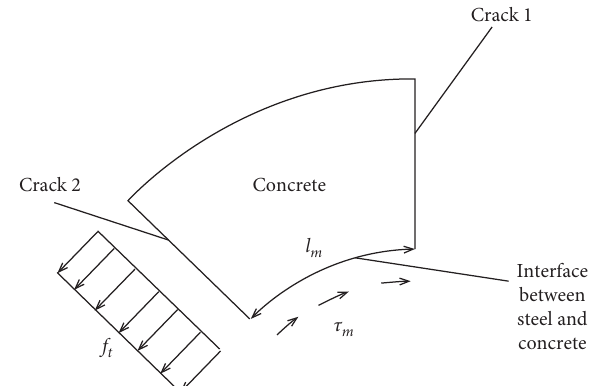
Figure 2: The concrete micromechanics are stressed within the effective tensile range between two cracks. f t —the tensile strength of concrete, N/mm 2 .